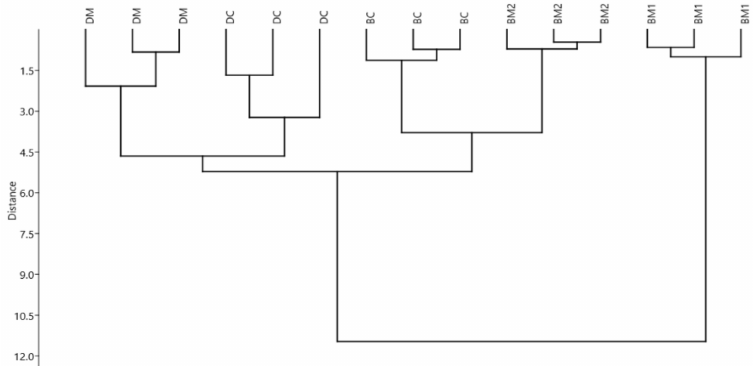
Figure 2. Multivariate cluster analysis (UPGMA algorithm – Manhattan distance) of di ff erent human milk fortifiers and protein concentrate (per g of added protein). Variables ( n = 3): antioxidant capacities (measured as TEAC, DPPH, and CAA (Cellular antioxidant activity)), haemolysis, protein carbonyl and malondialdehyde contents. BM1: bovine milk preterm fortifier type 1; BM2: bovine milk